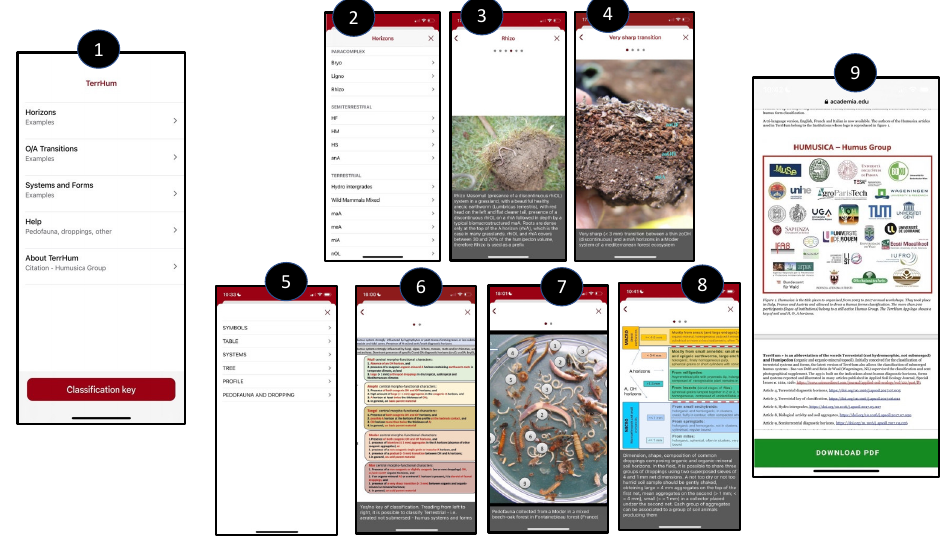
Figure 6. Main screen commands (1): ‘horizons’, ‘O/A transitions’, ‘systems and forms’, ‘help’ and ‘about TerrHum’. ‘Horizon’ command opens screen (2). To list available horizons, just touch a horizon